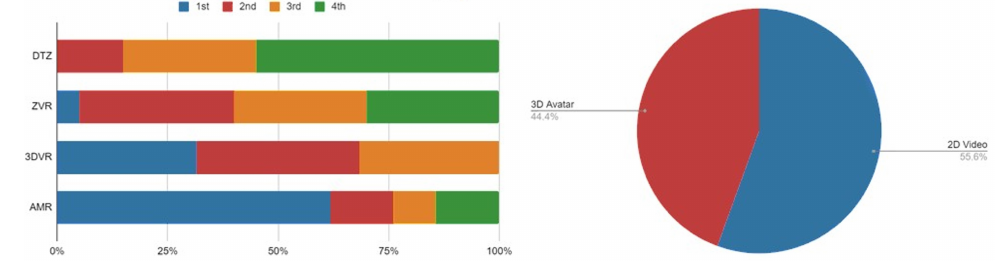
Figure 8. Preference based on the environment type ( left ) and avatar type ( right